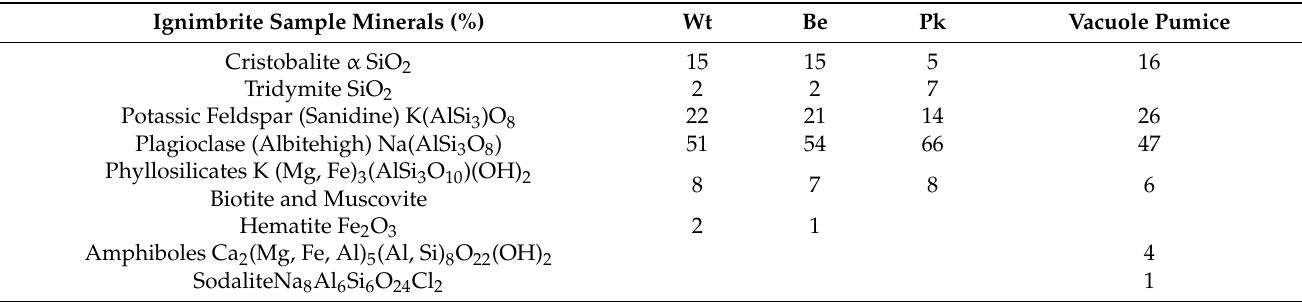
Table 1. Results of XRD semi-quantitative